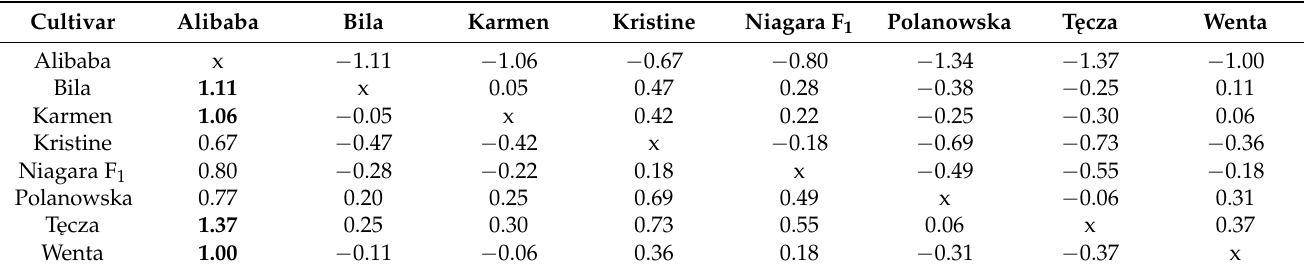
Table 4. Absolute colour difference ( ∆ H*) between leaf colours of onion cultivars in 2016. Cultivar